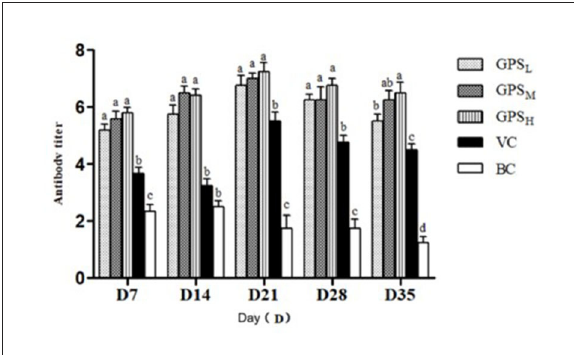
FIGURE7 Changes in serum antibody titer (Log2). a − d Values in the histogram with different letters indicate significant